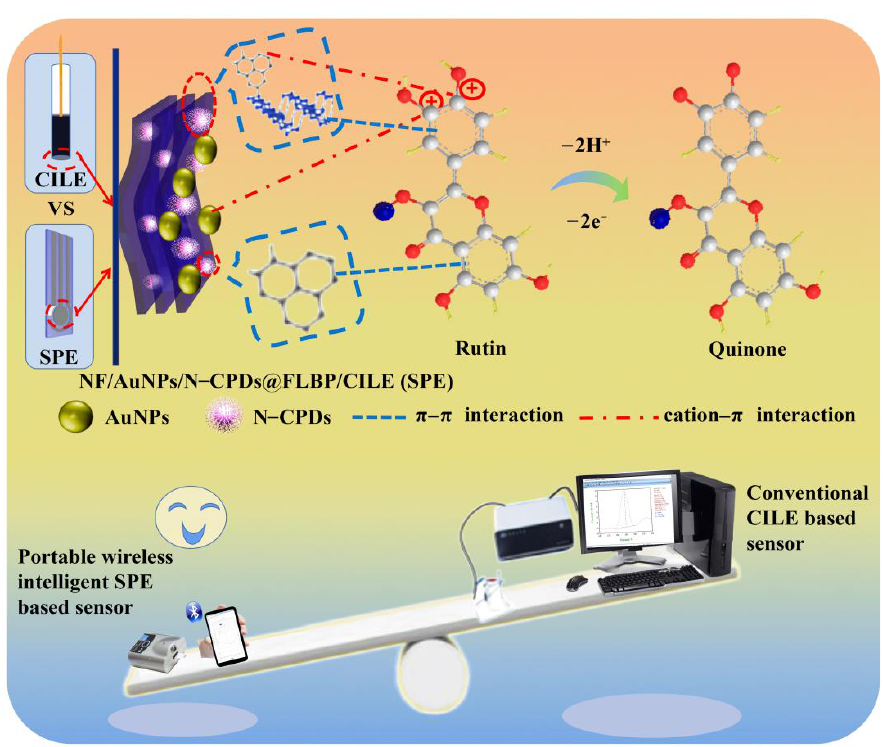
Figure 1. Diagram of electrochemical reaction mechanism of rutin on AuNPs/N-CPDs@FLBP/CILE (SPE) interface, and the performance comparisons of the conventional CILE-based sensor and portable wireless intelligent SPE-based sensor. (NF: nafion ethanol solution).